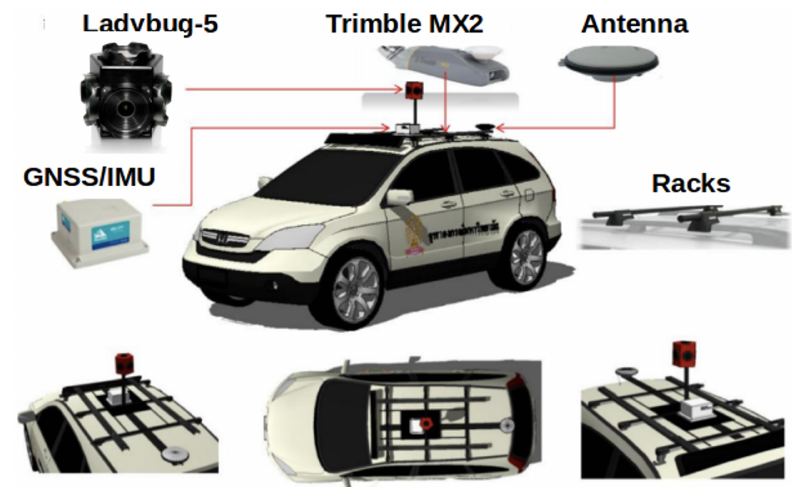
Figure 2. Our Ladybug5+ 360 degrees spherical camera.